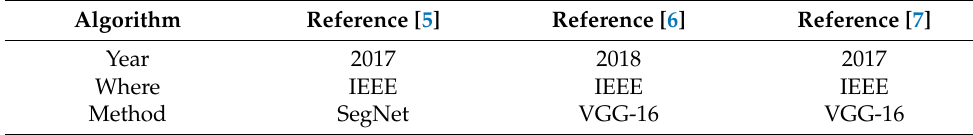
Table 2. Basic information of the Three algorithms.